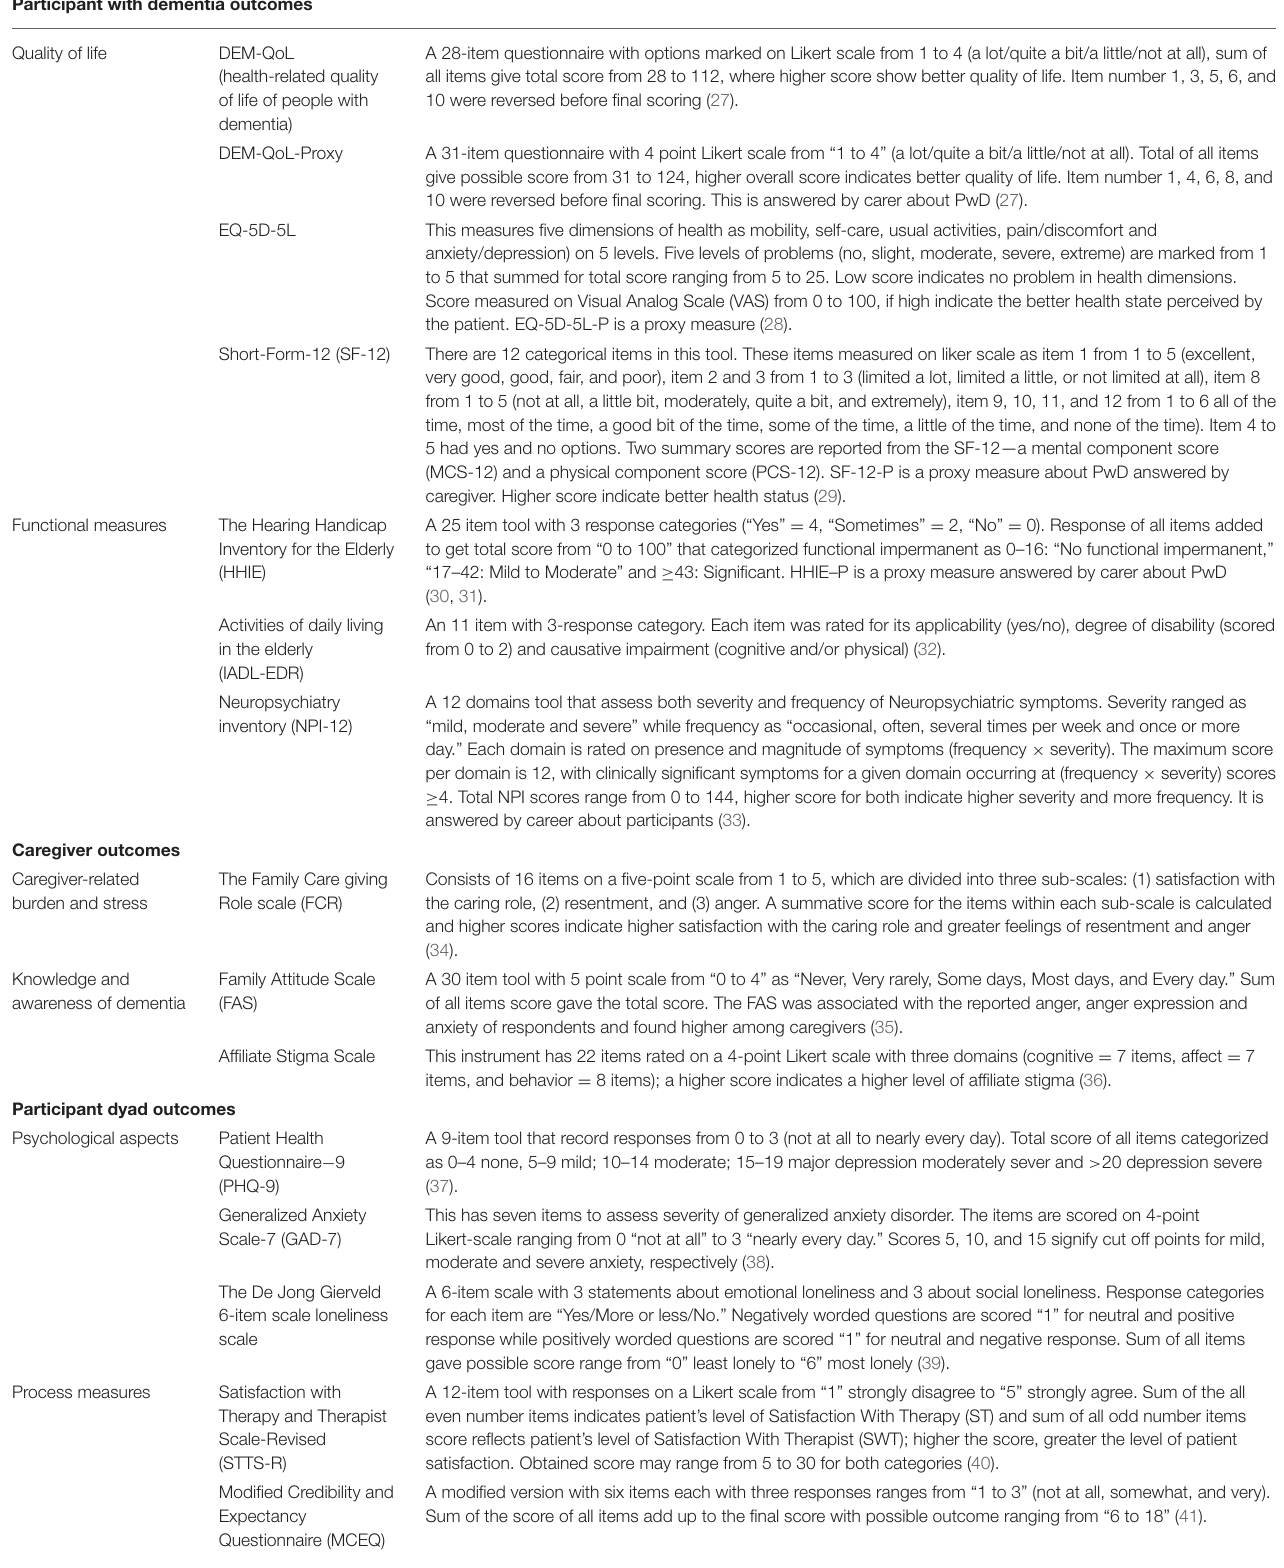
TABLE 4 | Outcome assessment measures. Participant with dementia